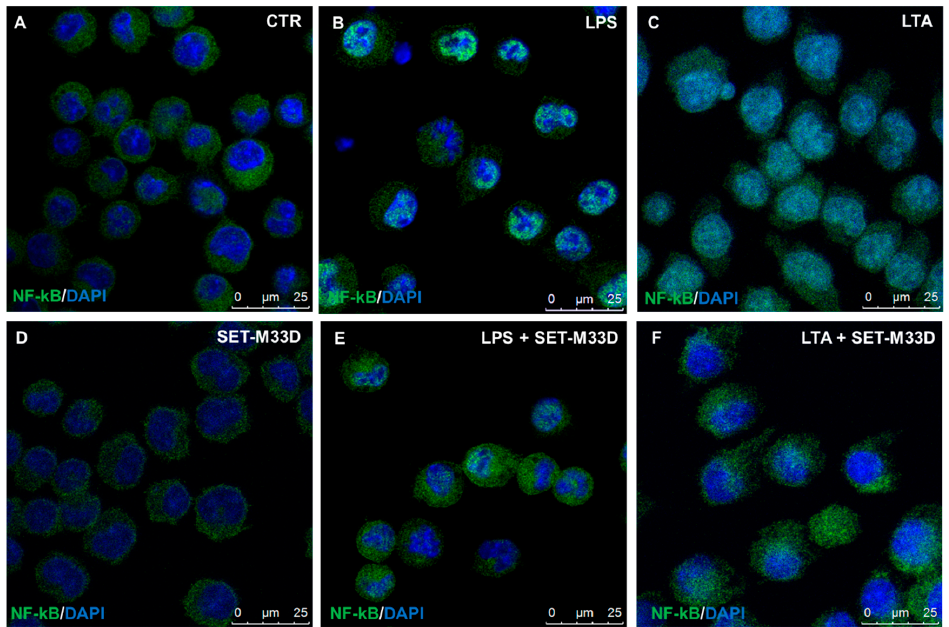
Figure 5. Immunofluorescence staining showing NF-kB/p65 distribution (green signal) in healthy RAW264.7 cells ( A ), stimulated with LPS from P. aeruginosa ( B ) or LTA from S. aureus ( C ) for 4 h, or